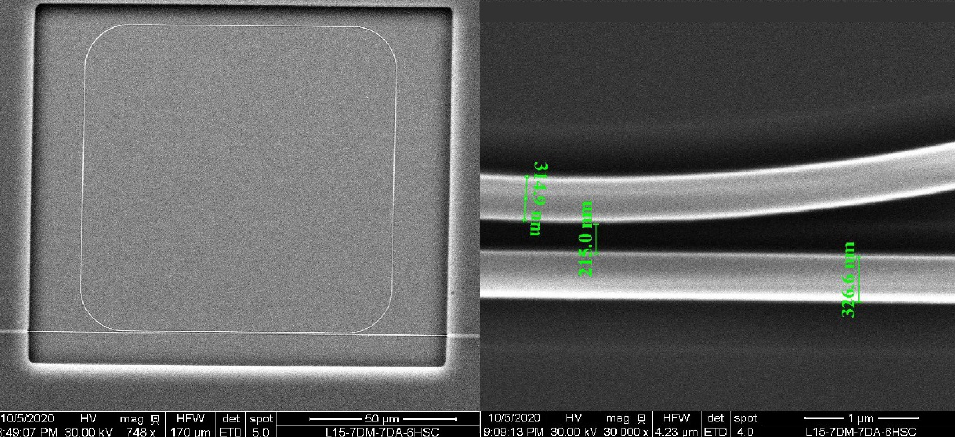
Figure 2. Scanning electron microscopy (SEM) image of the fabricated RCSS ( R c = 15 µ m) microres- onator for optical